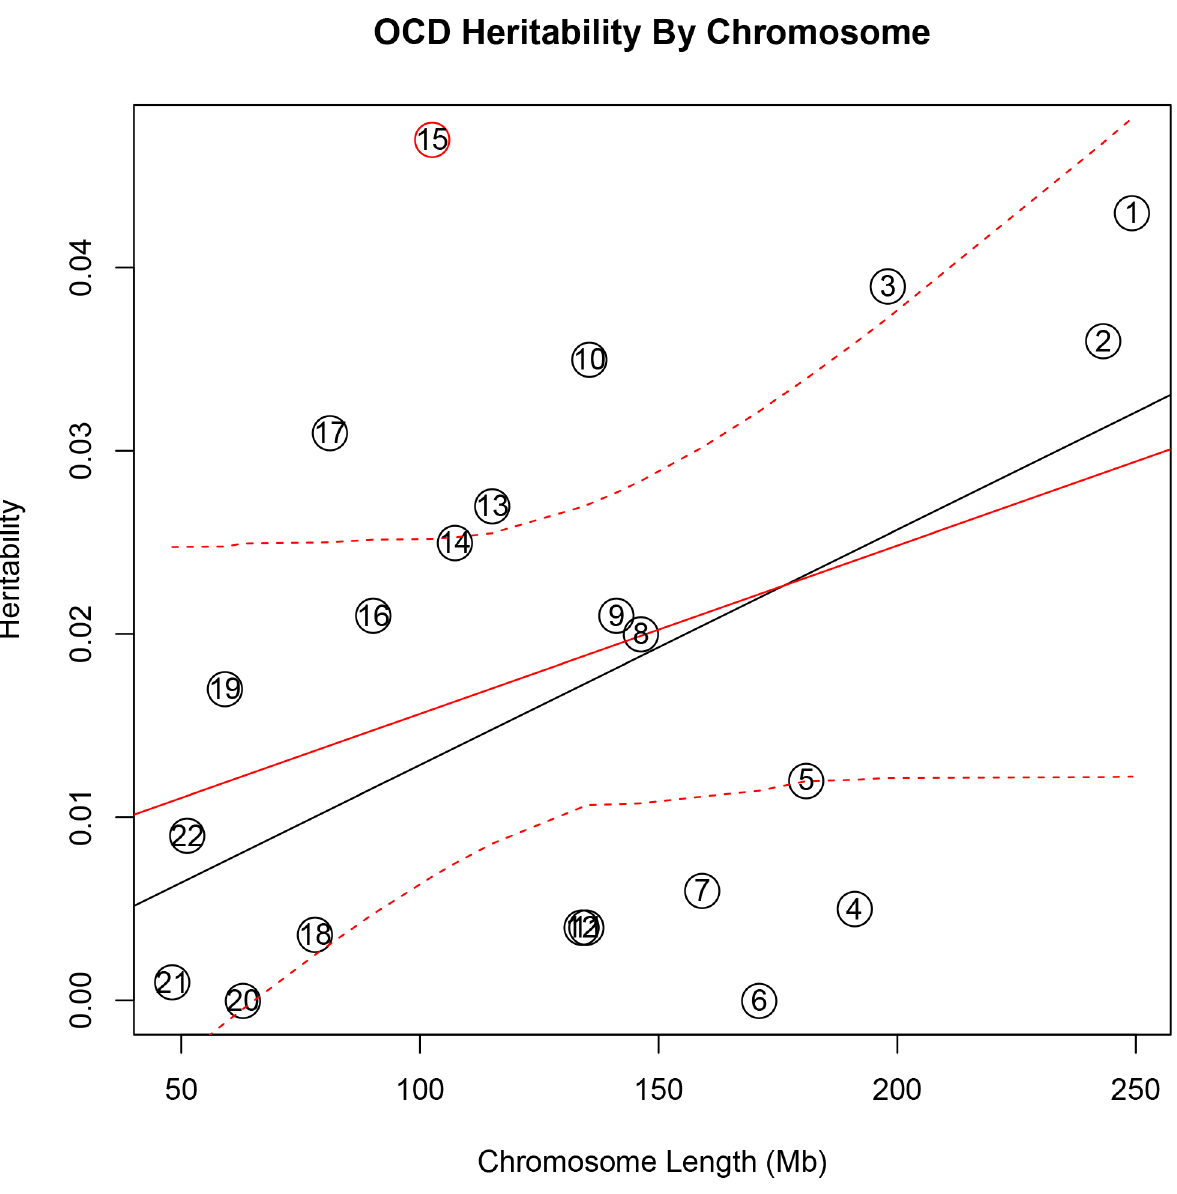
Figure 2. Obsessive-compulsive disorder heritability by chromosome. Heritability (y-axis) per chromosome is plotted against chromosome length (x-axis). The red line represents heritability regressed on chromosome length and the 95% confidence interval around the slope of the regression model is represented by the red dashed lines. The black line represents the expected heritability per chromosome (based on size) regressed on chromosome length. Chromosome 15 is shown in red to highlight its extreme deviation from the expected heritability based on chromosome length. Chromosomes 3, 10, 13, and 17 are also outside of the 95% interval and appear to account for more heritability than expected based on chromosome